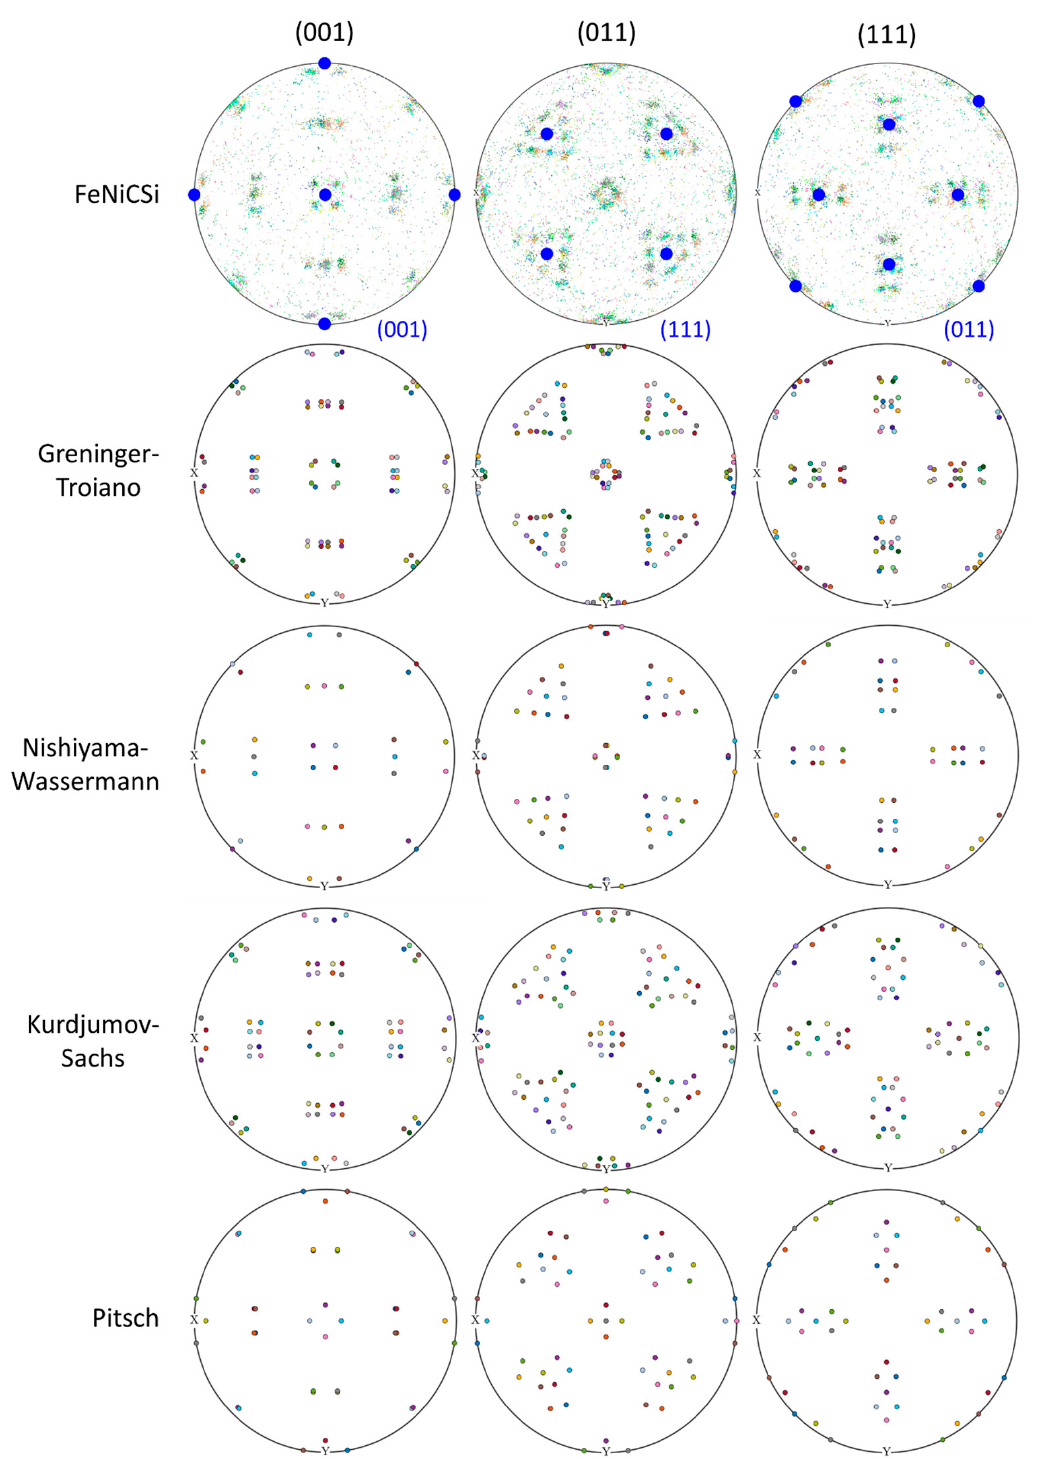
Figure 5. Pole figures calculated for different theoretical orientation relationships, namely Kurdjumov–Sachs (KS), Nishiyama–Wasserman (NW), Greninger–Troiano (GT), Pitsch and experimentally obtained data exemplarily shown for FeNiCSi, showing the reference austenite orientation in blue.